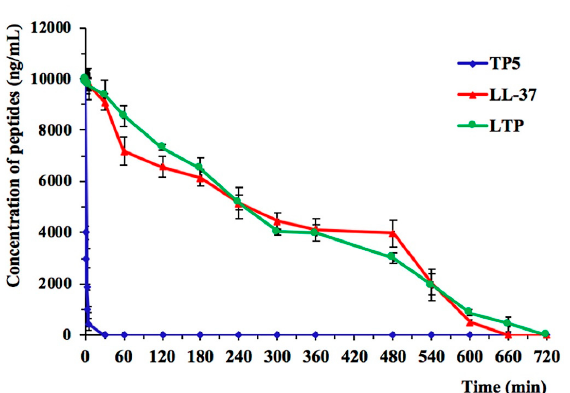
Figure 2. The mean plasma concentrations of LL-37, TP5, and LTP over times. The concentration of each target peptide in plasma in vitro at the selected times was quantified by HPLC. Data are given as the mean value ± standard error from three biological replicates. Table 2. Half-life of LTP in plasma.